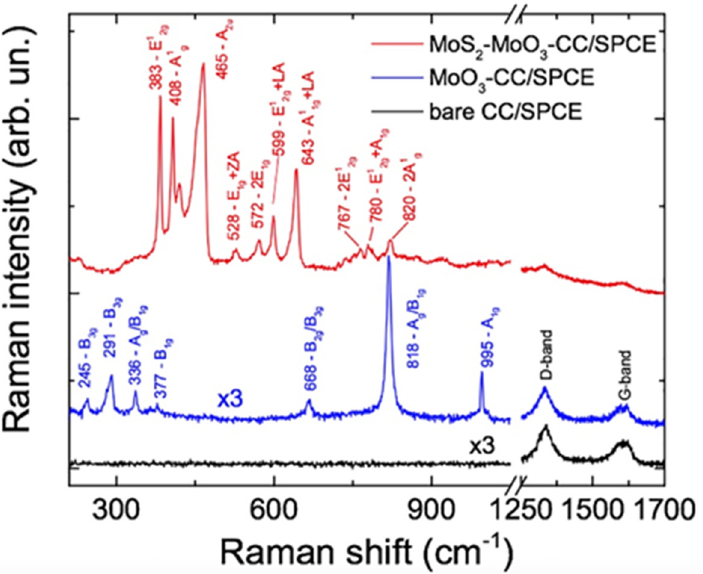
Figure 3. Raman spectra carried out at 638 nm on the CC/SPCE (black line), MoO 3 -CC/SPCE (blue line) and MoO 3 -CC-MoS 2 /SPCE (red line). The spectra on CC and MoO 3 -CC were multiplied by a factor 3 to fit the same intensity scale of the MoS 2 one. All spectra were offset for clarity.